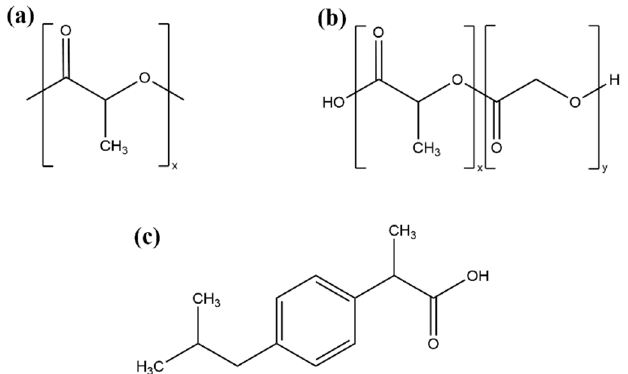
Figure 1. Chemical structures of used compounds: ( a ) PLA, ( b ) PLGA, and ( c ) IBU.